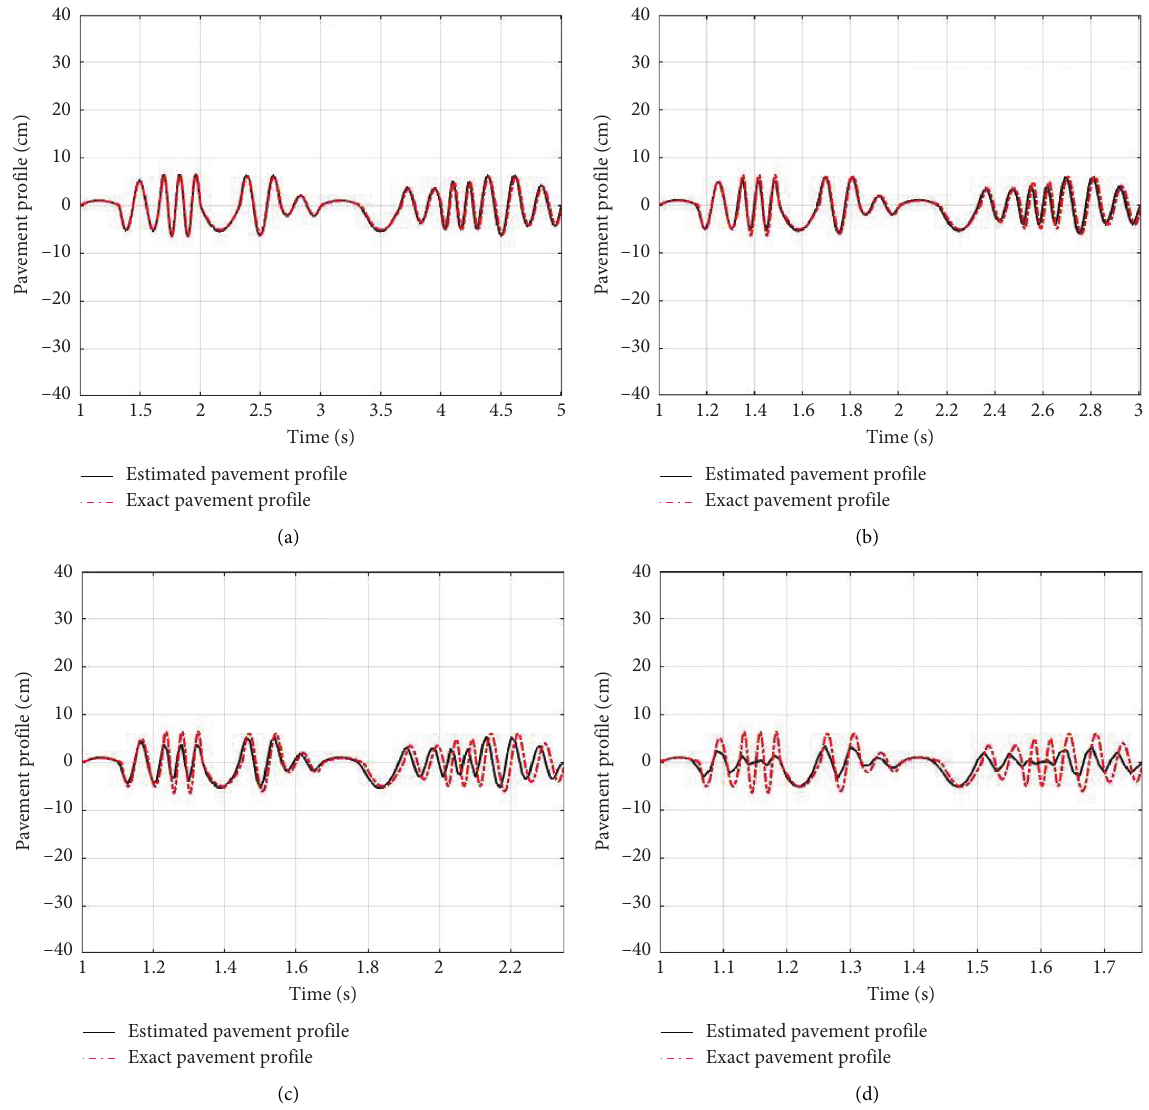
Figure 10: The estimated pavement profile for four different vehicle speeds. (a) Vehicle speed of 2.6 m/s. (b) Vehicle speed of 5.1m/s. (c) Vehicle speed of 7.8m/s. (d) Vehicle speed of